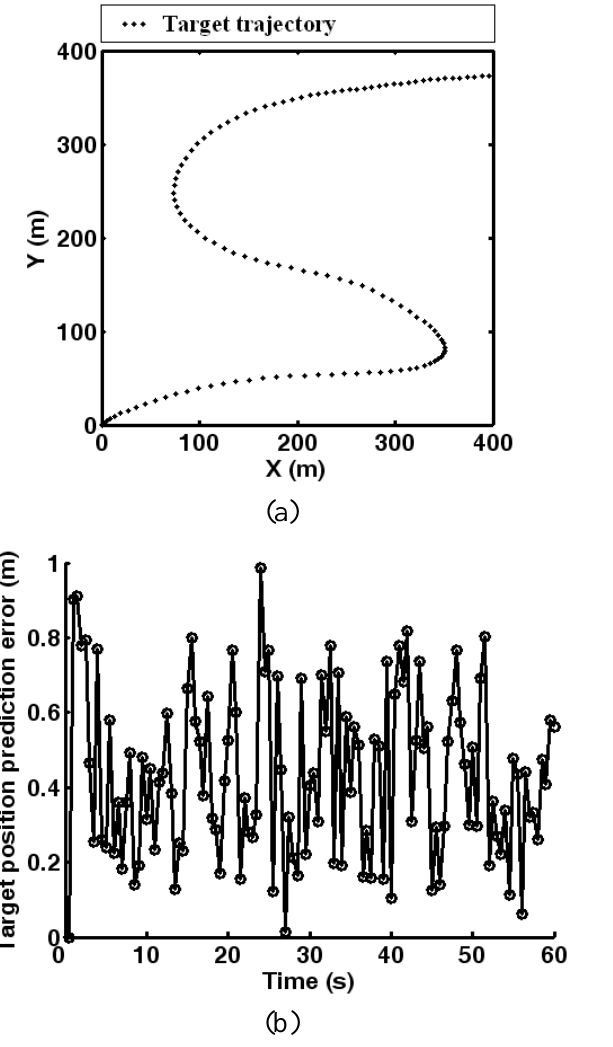
Figure 9. Target prediction results: (a) target trajectory; (b) position prediction error.